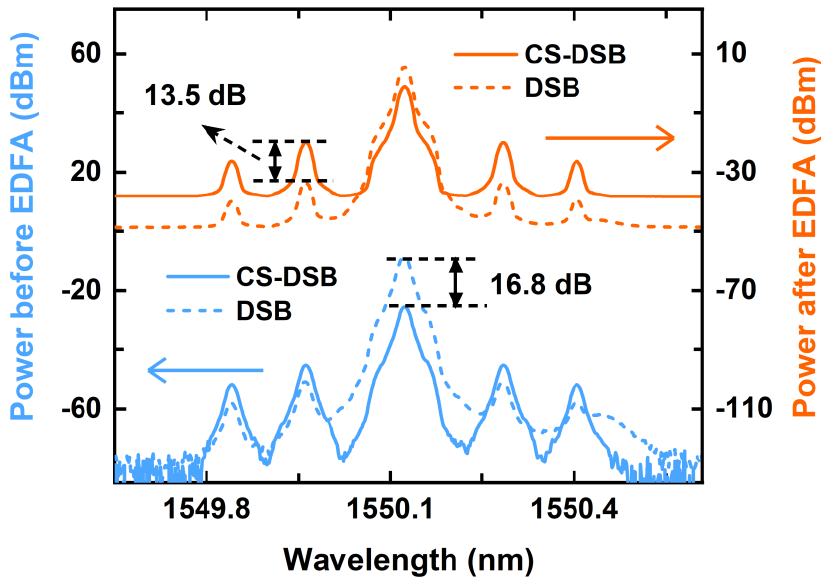
Figure 6. Measured optical spectrum before and after EDFA.